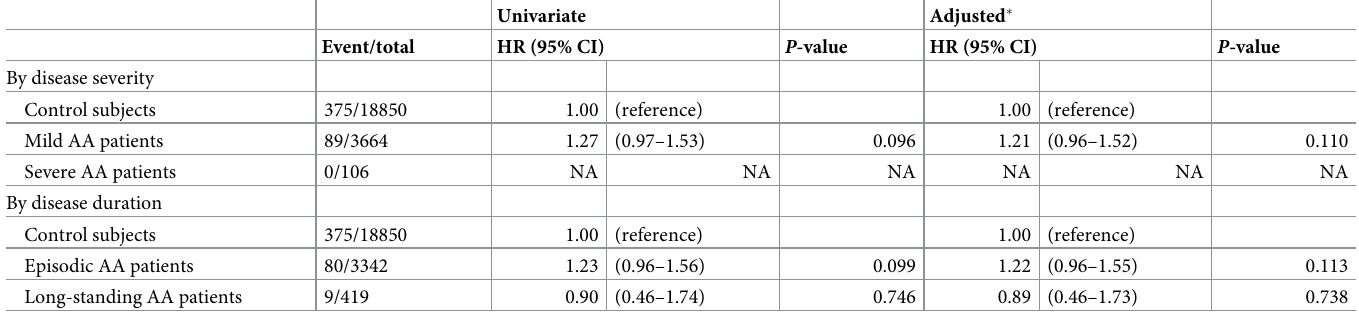
Table 3. Hazard ratio and 95% confidence intervals of heart diseases according to the subgroup analysis. Subgroup analysis was performed according to disease sever- ity and